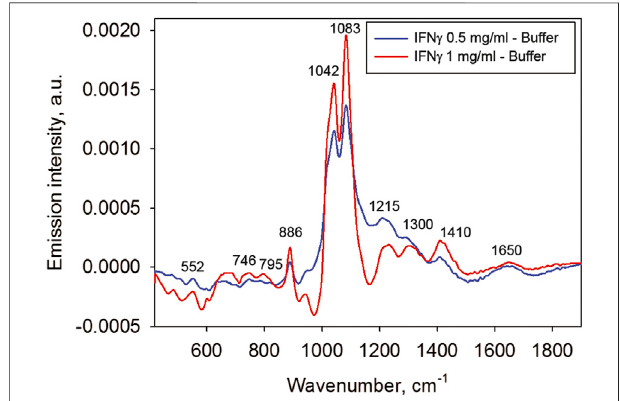
FIGURE 8 | The difference emission spectra of the IFN γ solutions (at 1 and 0.5 mg/ml concentrations) and the buffer.